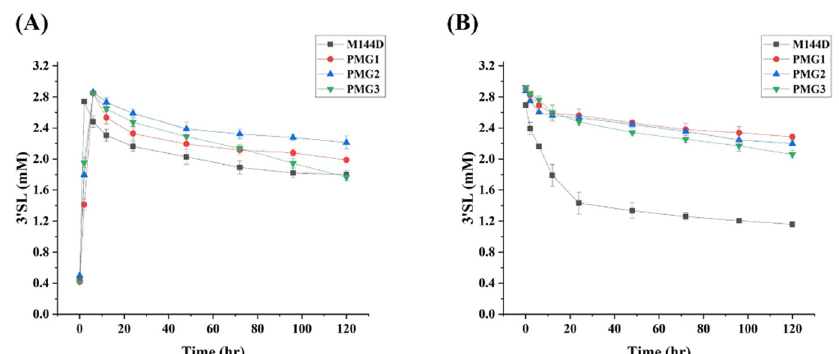
Figure 3. Some of the residues involved in substrate binding. Met144, Arg313, Glu271 and Thr265 in magenta are yet to be investigated. The catalytic residues Asp141 and His311 are in yellow and red. Lactose is in cyan and CMP-Neu5Ac in green.